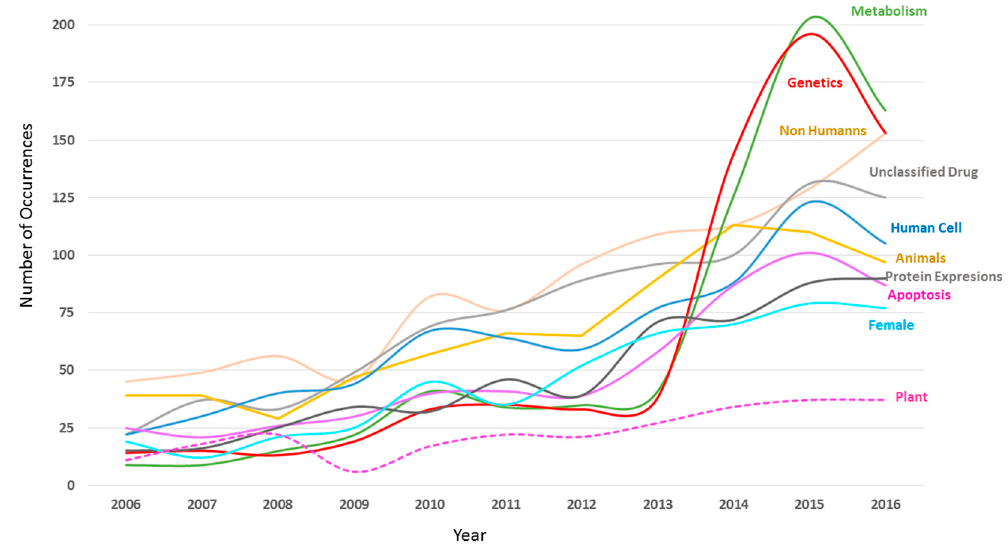
Figure 5. Top ten keywords and Plant keyword evolution related to worldwide DDR research (2006–2016).